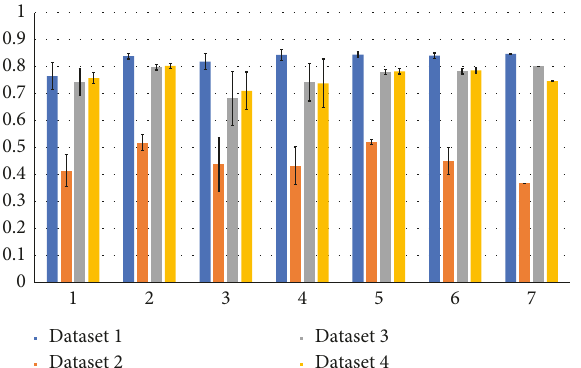
Figure 5: The mean accuracy results (with standard deviation) of various data augmentation techniques for Vietnamese sentiment analysis in 10 runs based on the deep learning